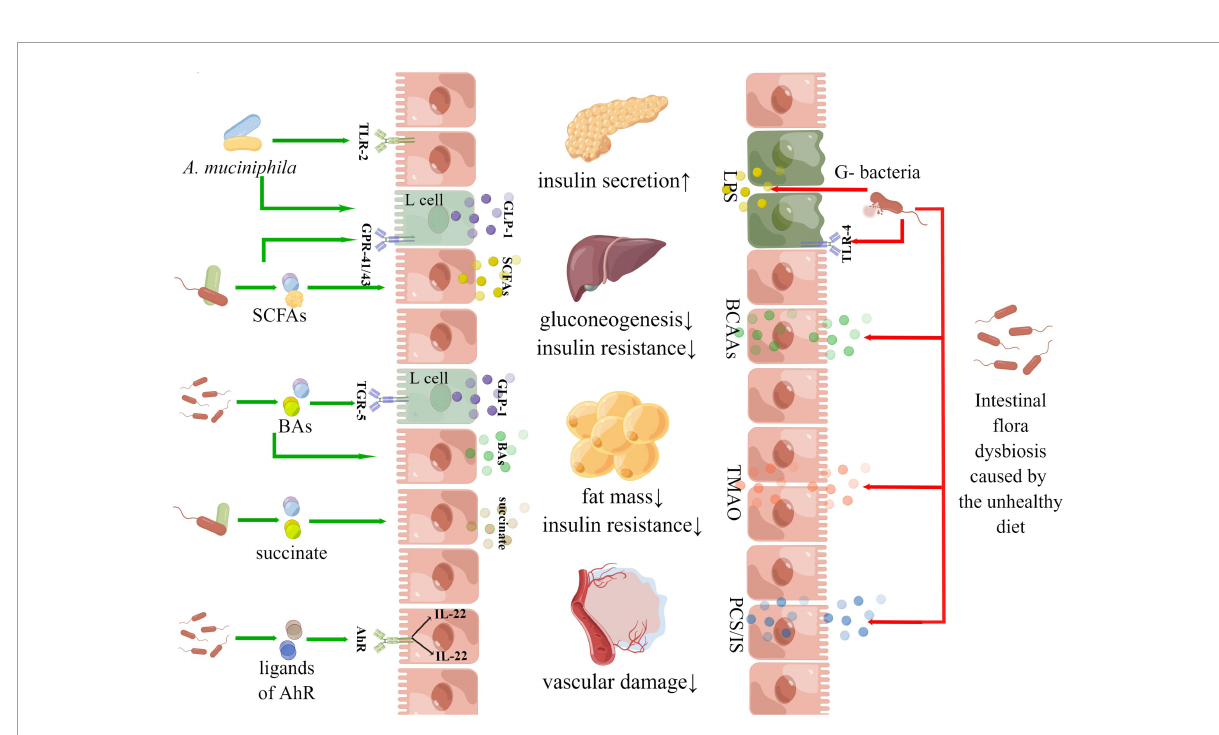
FIGURE8 Diagram of hotspot mechanisms in the “gut microbiota and diabetes”